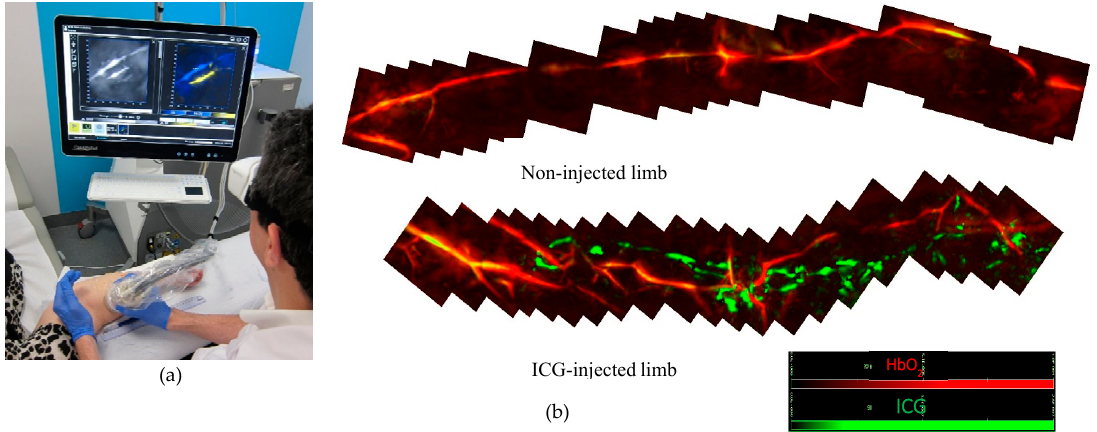
Figure 1. ( a ) Bedside Multispectral Optoacoustic Tomography (MSOT) examination. ( b ) In the injected limb both lymphatics (green) and blood vessels (red) were detected while in the non-injected limb, only blood vessels (red) could be detected.